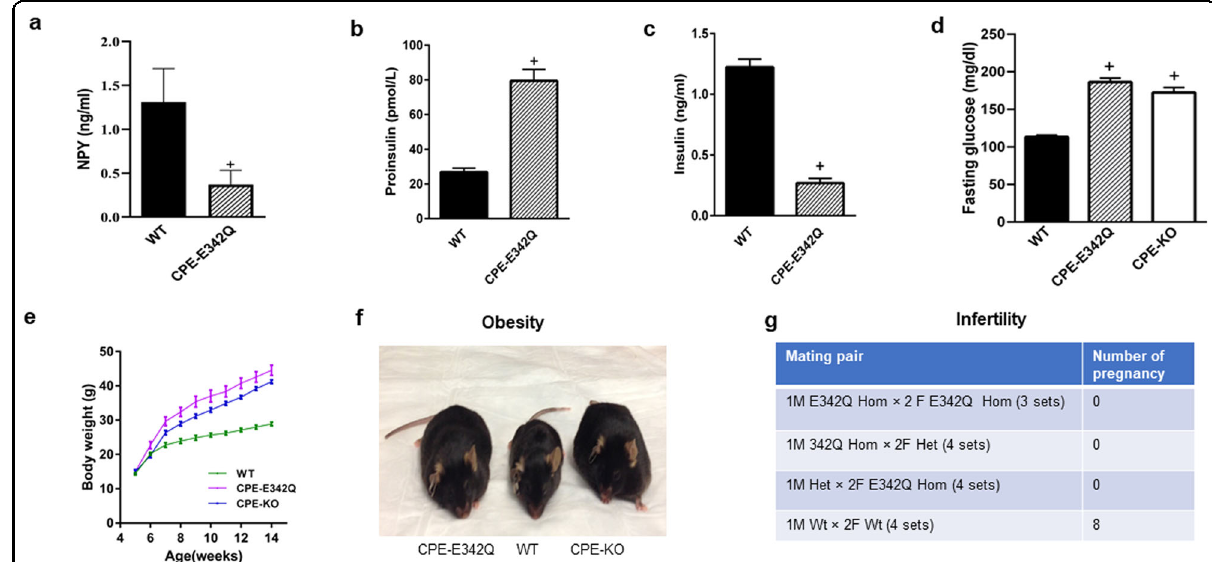
Fig. 2 Neuroendocrinological de fi cits in CPE-E342Q mice due to lack of CPE enzymatic activity. a NPY analysis in CPE-E342Q mouse hypothalamus. Protein was extracted from WT and CPE-E342Q ( n = 3 each) mouse hypothalamic extracts and NPY was measured using a mature NPY speci fi c EIA kit. WT and CPE-E342Q ( n = 3 each) hypothalamic tissue extracts were also separated on reverse phase HPLC column and fractions corresponding to NPY standard were analyzed by the NPY EIA kit. Bar graphs show collective result for both total and HPLC analyzed tissue samples ( n = 6 mice). Note the 71.85% decrease in the level of mature NPY peptide in CPE-E342Q compared to WT mice, Mann Whitney ’ s non-parametric test, + p = 0.0152, values are mean ± SEM. b Bar graphs show proinsulin in CPE-E342Q mice at 12 weeks of age was signi fi cantly increased in comparison with WT mice (WT = 26.9 ± 1.008 pmol/L, CPE-E342Q = 79.48 ± 2.94 pmol/L), Student ’ s t test, + p < 0.0001 for CPE-E342Q mice compared with WT. The values are the mean ± SEM, n = 5 mice per group. c Bar graphs show insulin in CPE-E342Q mice at 12 weeks of age was signi fi cantly decreased in comparison with WT mice (WT = 1.223 ± 0.03 ng/ml, CPE-E342Q = 0.269 ± 0.017ng/ml). Student ’ s t test, + p < 0.0001 for CPE-E342Q mice compared with WT. The values are the mean ± SEM, n = 5 mice per group. d Bar graphs show fasting glucose levels were signi fi cantly higher in CPE- KO and CPE-E342Q mice in comparison with WT mice. One-way ANOVA analysis followed by Tukey ’ s post hoc multiple comparison test, [ F (2,45) = 92.62, p < 0.0001]. + p < 0.0001 for both CPE-E342Q and CPE-KO mice compared with WT. The values are the mean ± SEM, n = 12 for CPE-KO, n = 12 for CPE-E342Q, n = 24 for WT. e Body weight of CPE-KO, CPE-E342Q, and WT mice. Weights of male and female WT, CPE-KO, CPE-E342Q mice were recorded from 5 to 14 week of age. The values are the mean ± SEM, n = 12 for CPE-KO, n = 12 for CPE-E342Q, n = 24 for WT. f Photograph showing the size of CPE-E342Q, WT and CPE-KO mice at 32 weeks of age. Note the obesity of CPE-E342Q and CPE-KO mice. g Fertility evaluation of CPE-E342Q mice compared with WT. Table shows CPE-E342Q homozygote mice are infertile. Hom = homozygote, Het = heterozygote, Wt = wild type. Mice were 6 – 9-week